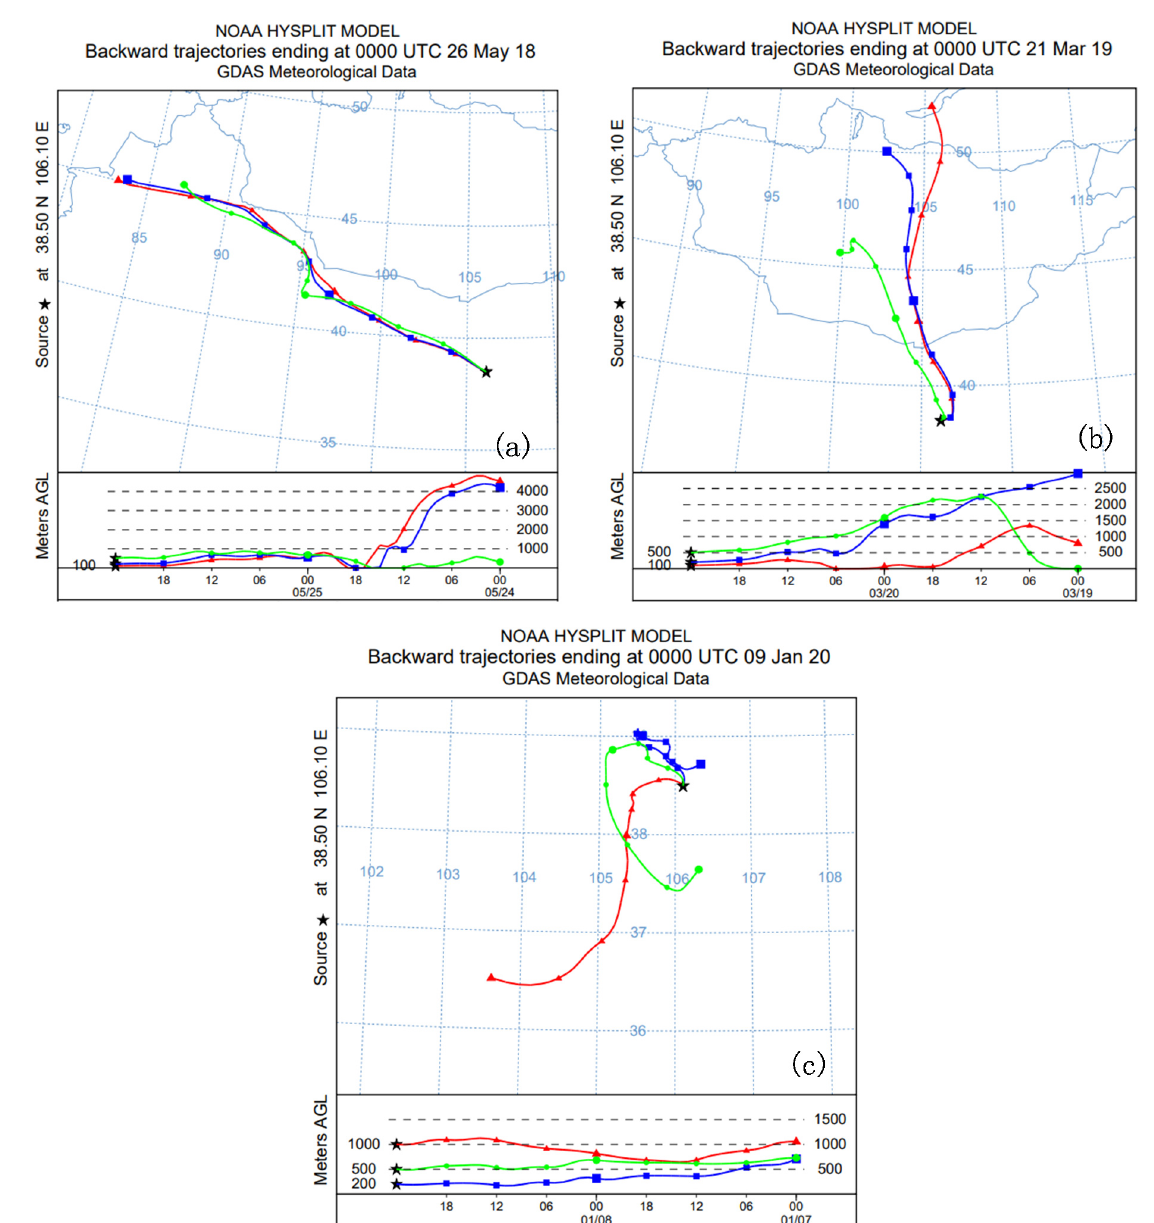
Figure 9. The backward trajectory in Yinchuan area on ( a ) blowing dusty days, ( b ) floating dusty days and ( c ) hazy days.